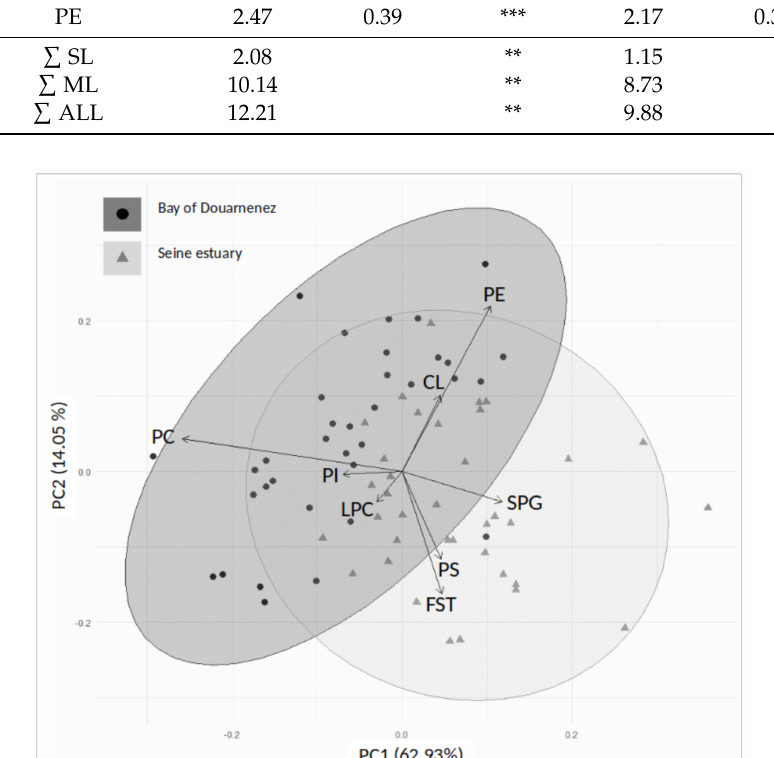
Figure 4. Principal component analysis (axes 1 and 2). Distribution of membrane phospholipids on the correlation circle, and individuals on the factorial plan, in the Douarnenez and Seine populations. SPG: sphingomyelin, LPC: lysophosphatidylcholine, PC: phosphatidylcholine, PS: